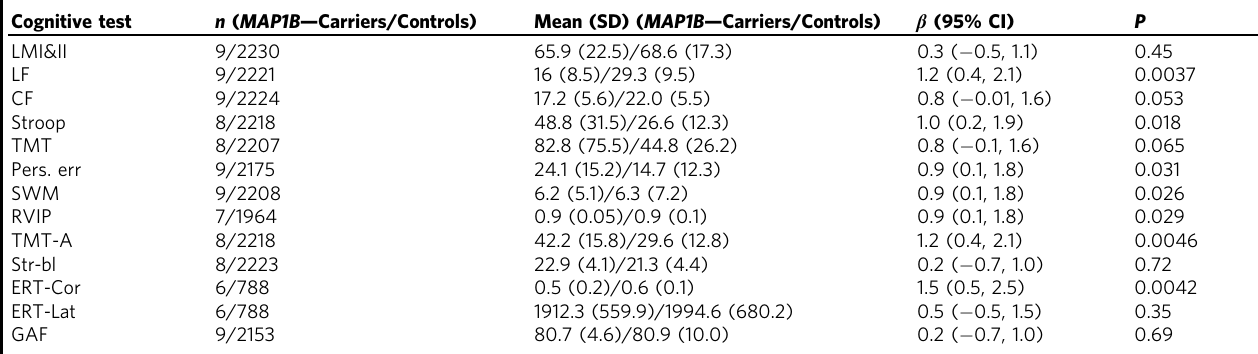
Table 2 Cognitive assessment test scores for MAP1B LoF carriers compared with controls Cognitive test n ( MAP1B — Carriers/Controls) Mean (SD) ( MAP1B — Carriers/Controls)